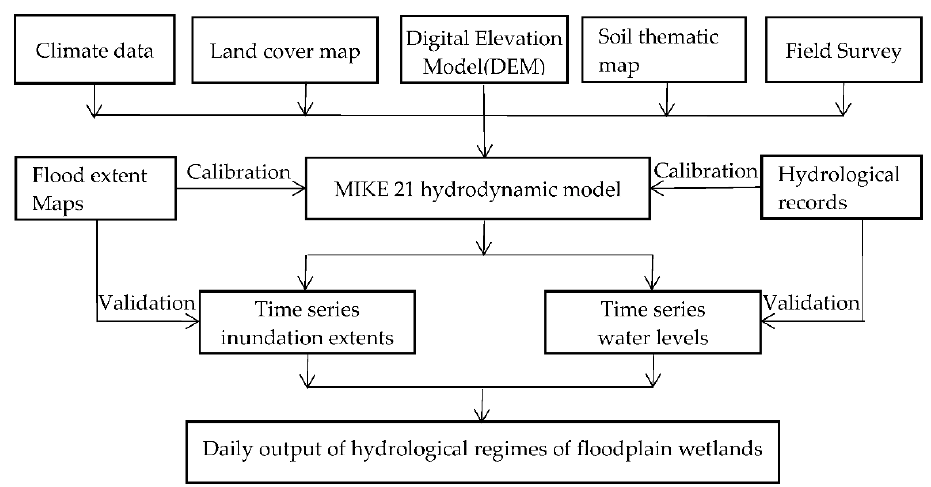
Water 2022 , 14 , x FOR PEER REVIEW 6 of 12 Figure 2. Flowchart of the calibration and validation process used to build the hydrodynamic model.